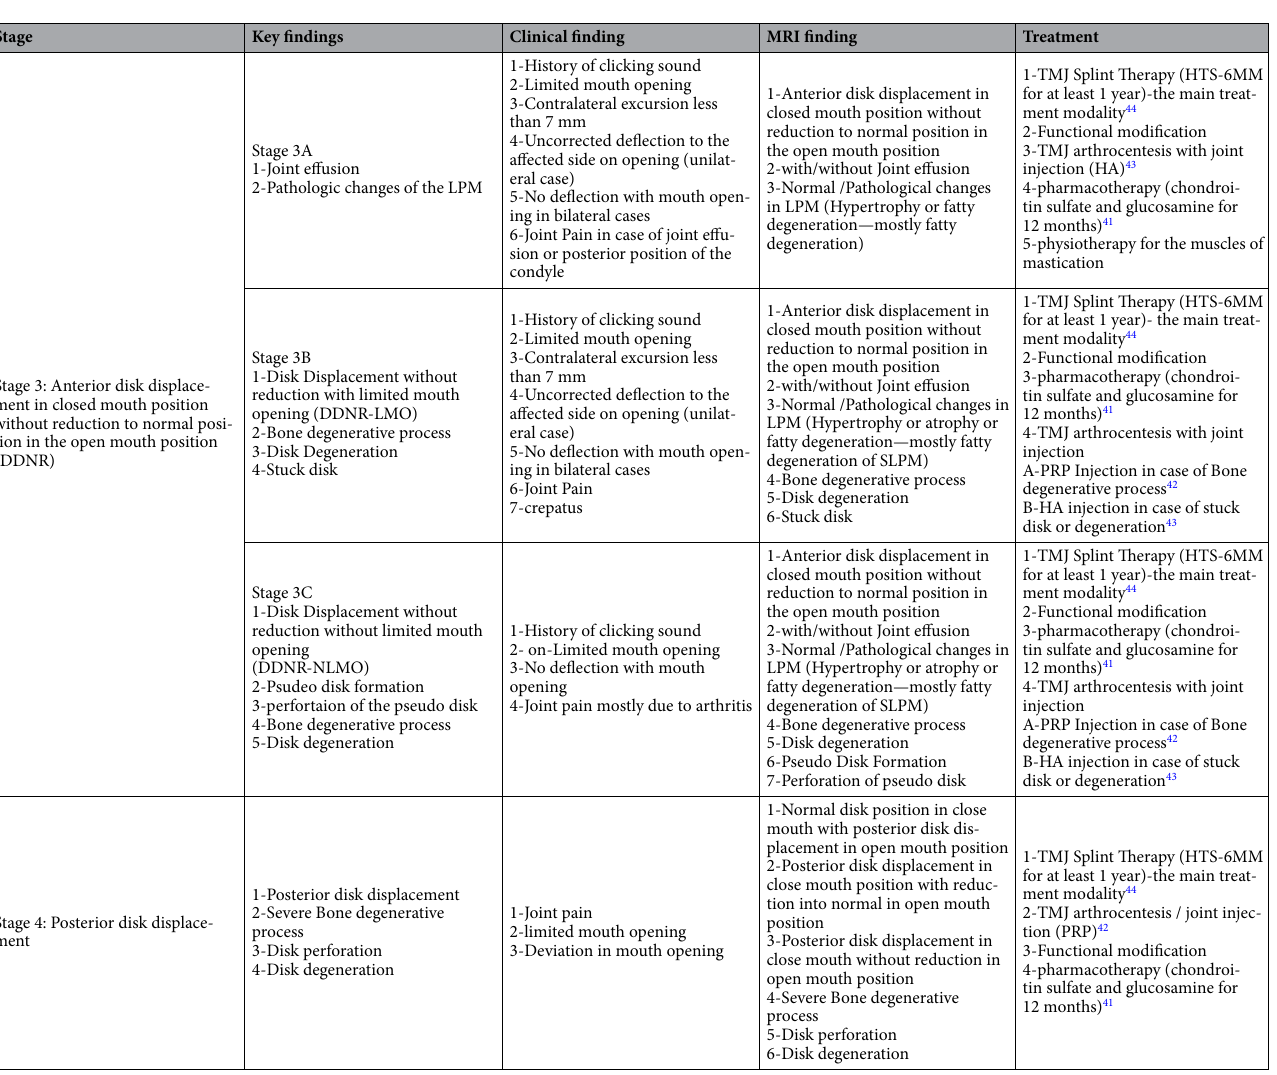
Table 1. Detailed description of clinical and MRI finding of the new classification system and treatment protocol for each stage. Classification of temporomandibular joint internal derangement. TMJ: Temporomandibular joint, LPM: Lateral Pterygoid muscle, HTS: Hegab Temporomandibular joint splint, PRP: platelets rich plasma, HA: Hyaluronic